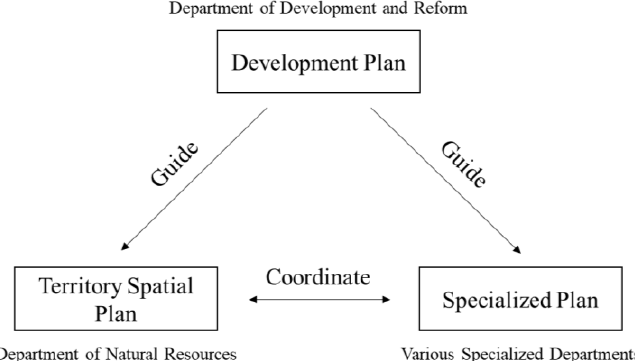
Figure 1. China ’ s planning system. Figure 1. China’s planning